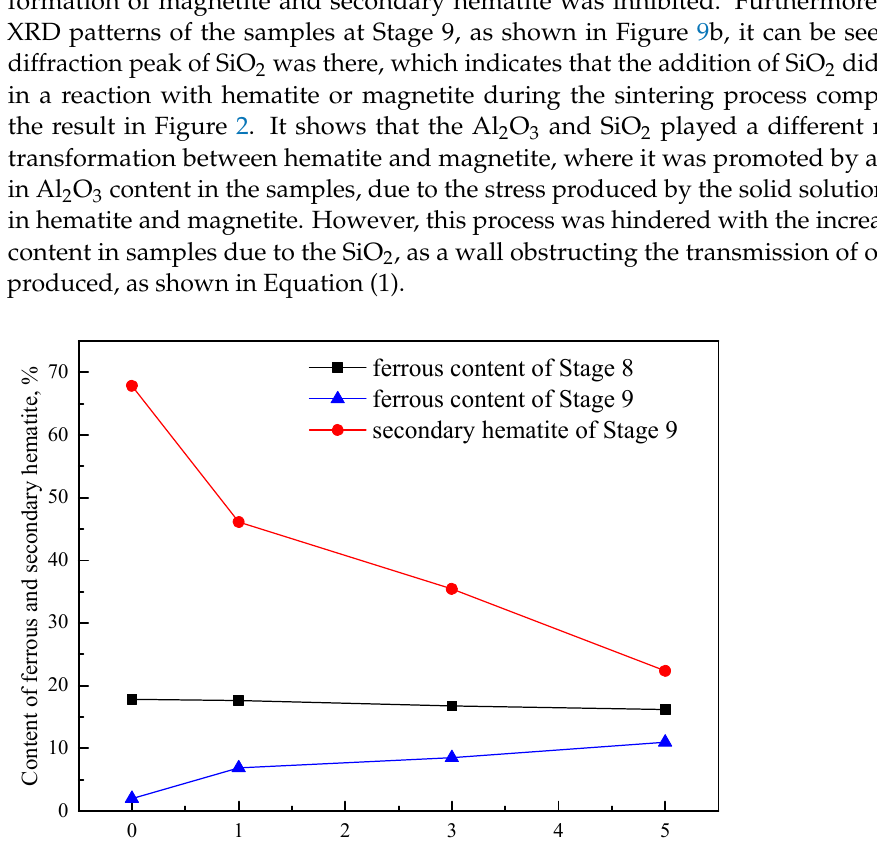
Figure 7. Effect of MgO addition on formation of secondary hematite.